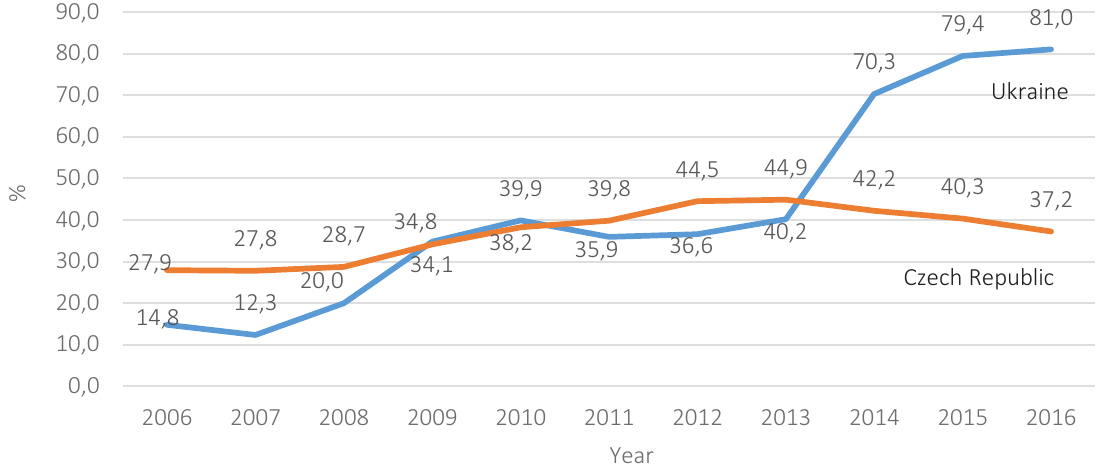
Source: CEIC (2018).